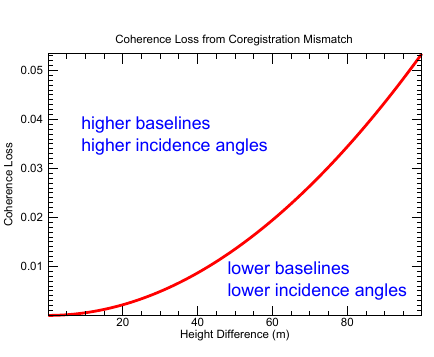
Figure 5: Coherence loss due to a coregistration mismatch in a typical TanDEM-X scenario.